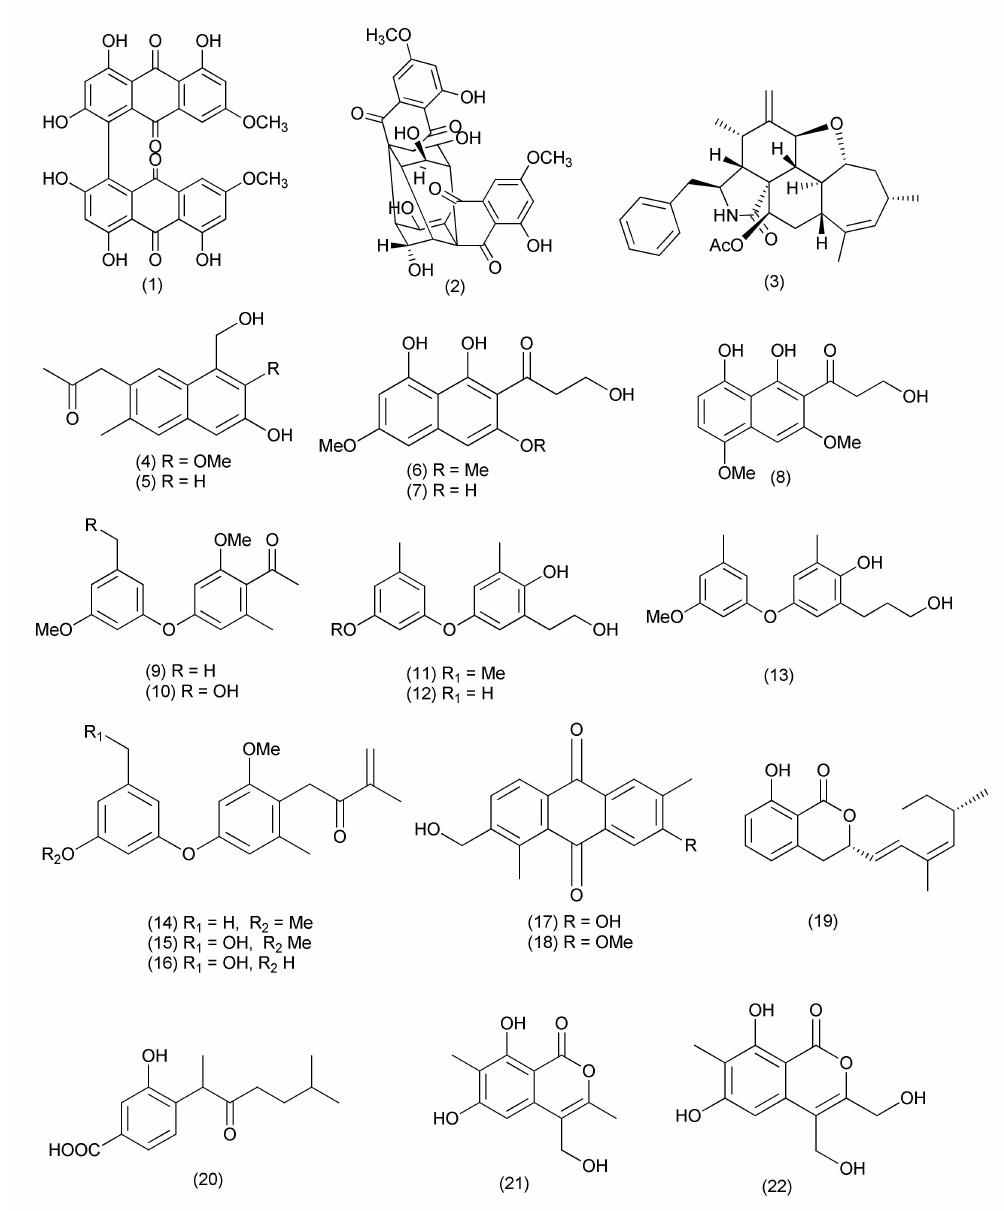
Figure 1. Structures of metabolites 1 – 22 isolated from